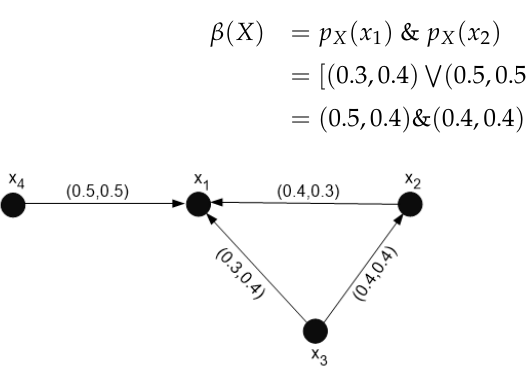
Figure 2. Example of an IFG.